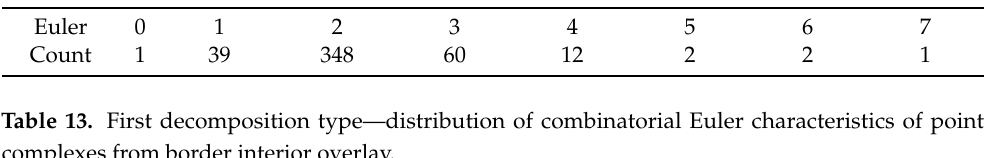
Table 12. Third decomposition type—distribution of combinatorial Euler characteristics of Seg- ment3DNet objects from border interior overlay.